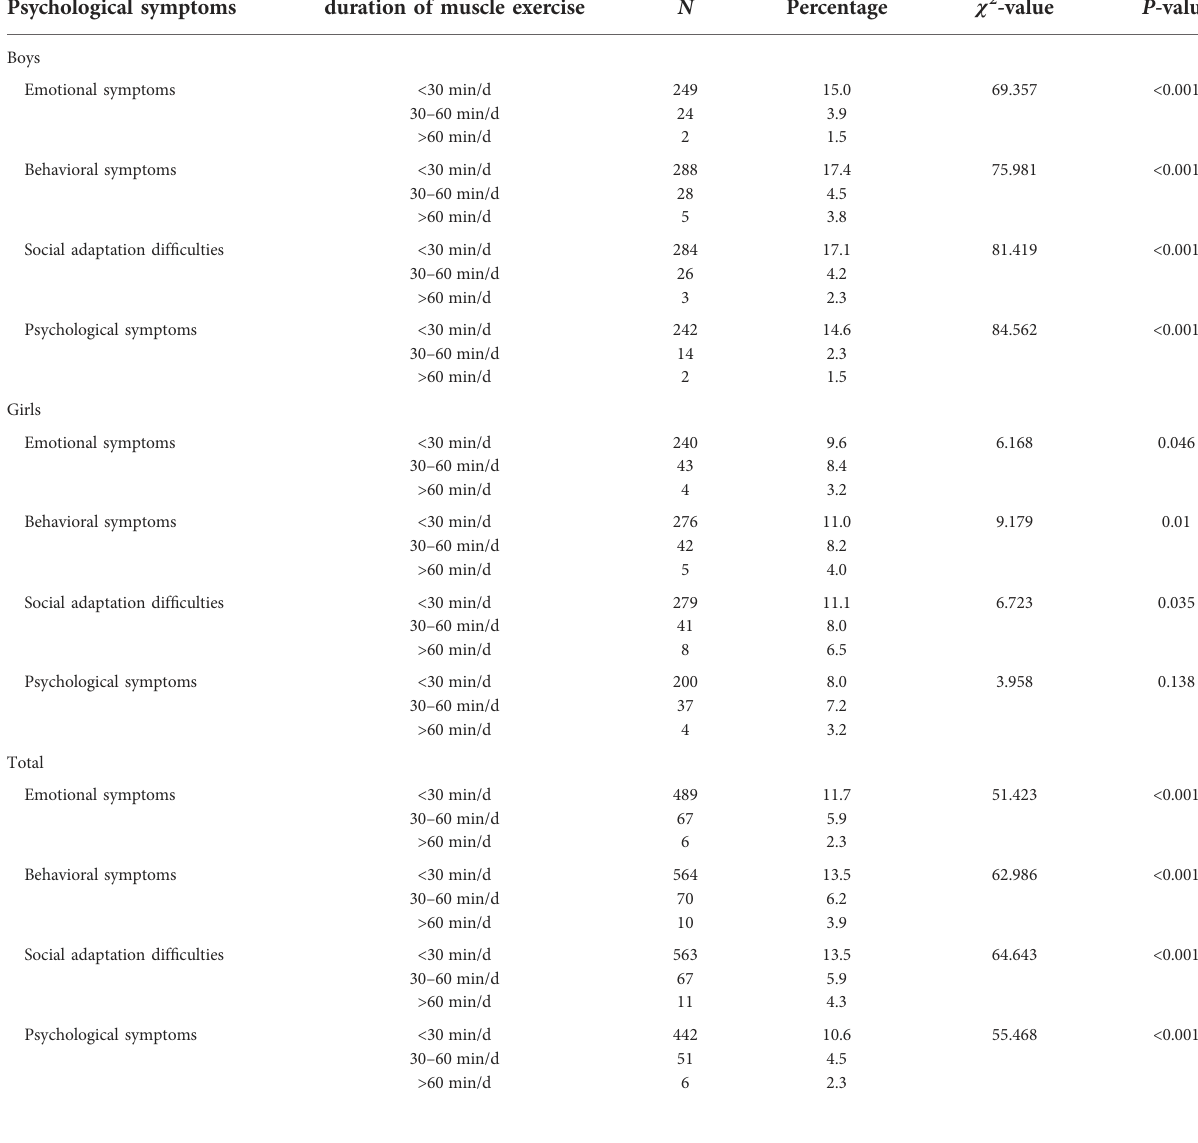
TABLE 2 Comparison of the detection rate of psychological symptoms among Chinese college students in duration of muscle exercise. Psychological